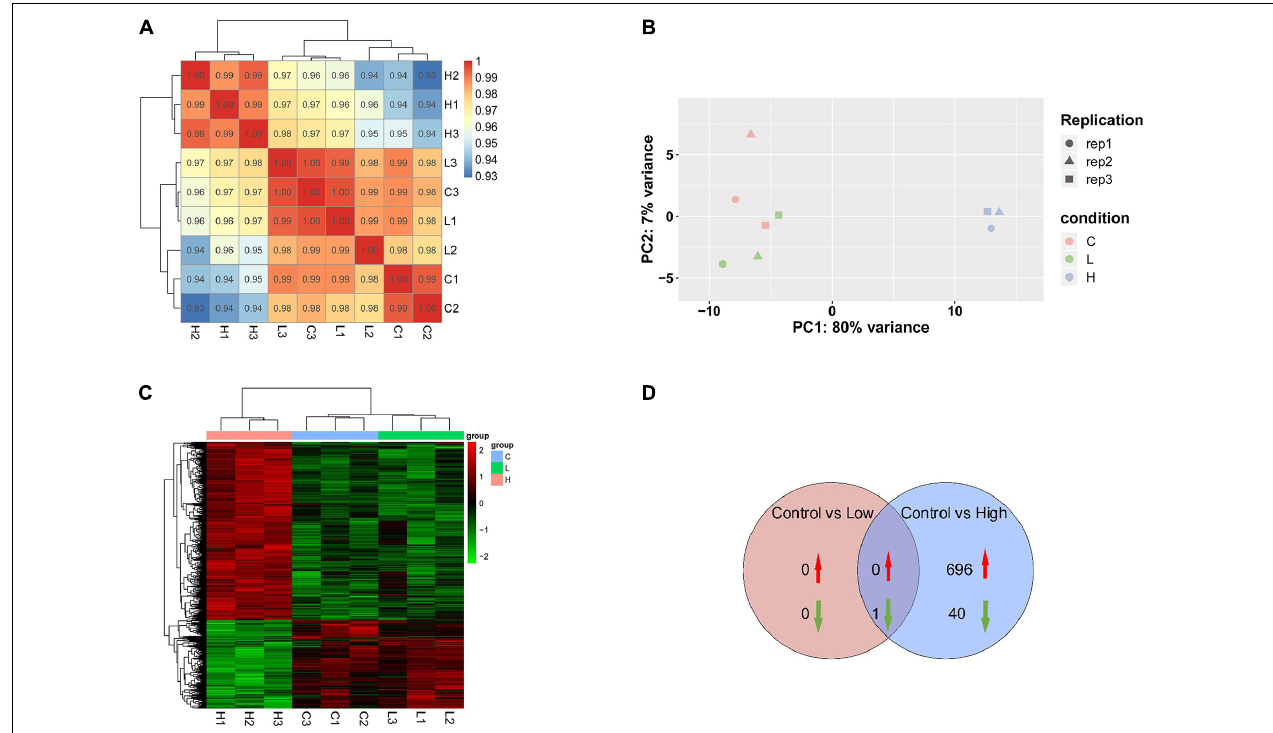
FIGURE 2 | Transcriptomic profile of R. subcapitata treated with SMX for 7 days. (A) Correlation analysis of gene expression patterns control and SMX-treated groups. (B) Principal component analysis (PCA) of FPKM profiles of DEG. (C) A heatmap of centered and scaled FPKM values of DEGs in the controls and SMX-treated group. (D) Venn diagram of DEGs in each